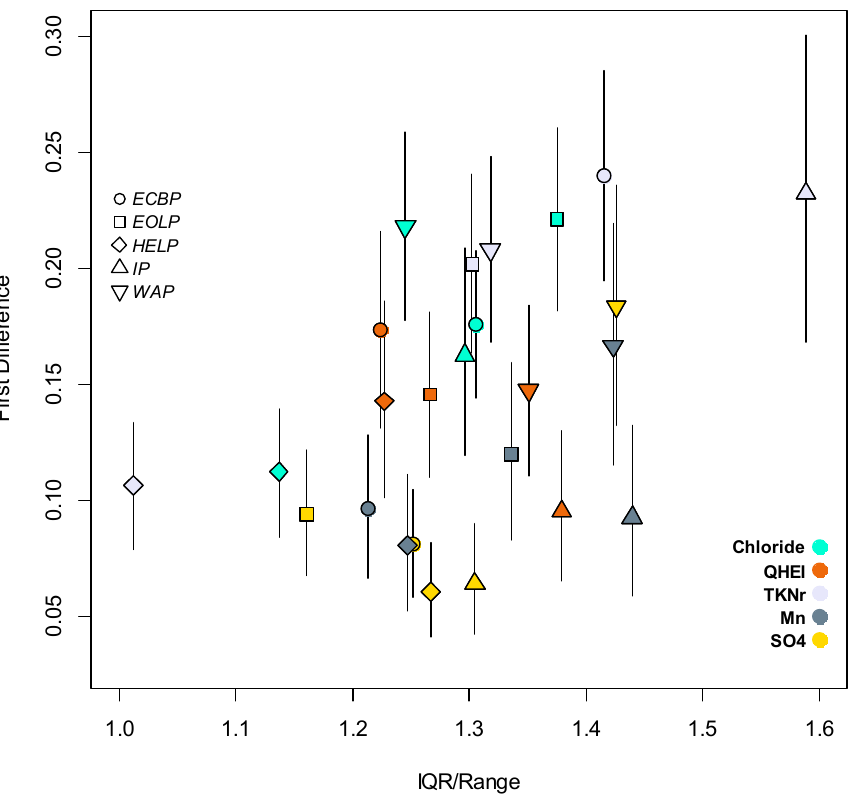
Figure 5. First differences (+/ − 95% credible interval) as a function of scaled interquartile ranges. Note that absolute values for the first differences are plotted on the